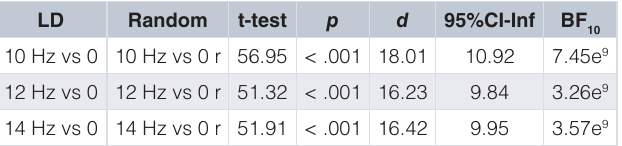
Table 5. Inferential statistics and parameters estimation of the comparison of the percentage of correct classification of the periods of stimulation and non-stimulation between the linear discriminant and the random classifier in the stimulated